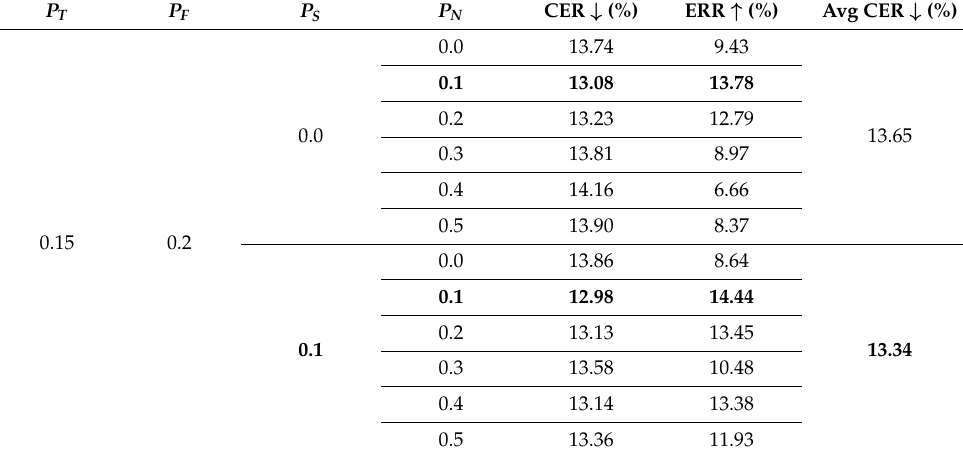
Table 10. ASR Performance comparison according to the variations of P S and P N in the pretraining of the SVR model. All the results are from training the ASR model using the pretrained SVR extractor kept frozen. We report on the KsponSpeech ASR performance (Matched-SVR1K). The respective bolds represent the best hyperparameter and